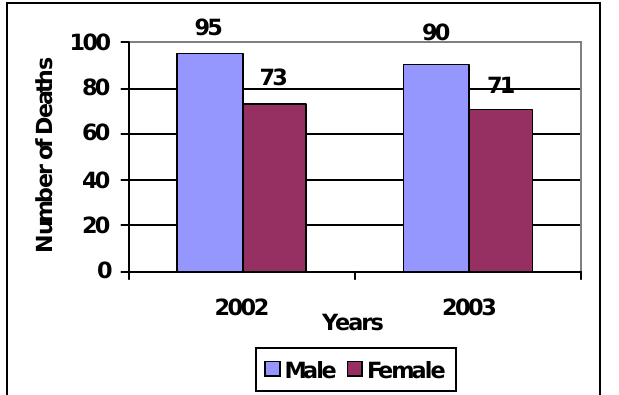
Fig. 10 : JE Death: Gender, 2002 - 2003